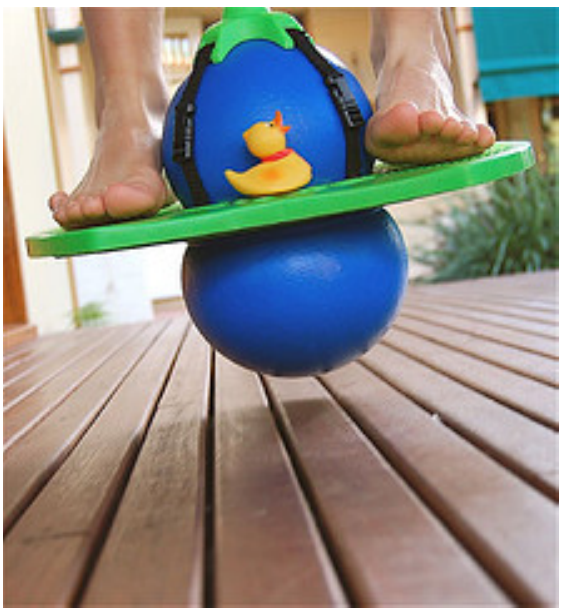
Figure 8: ‘Duck and Zoingo Boingo together’ by